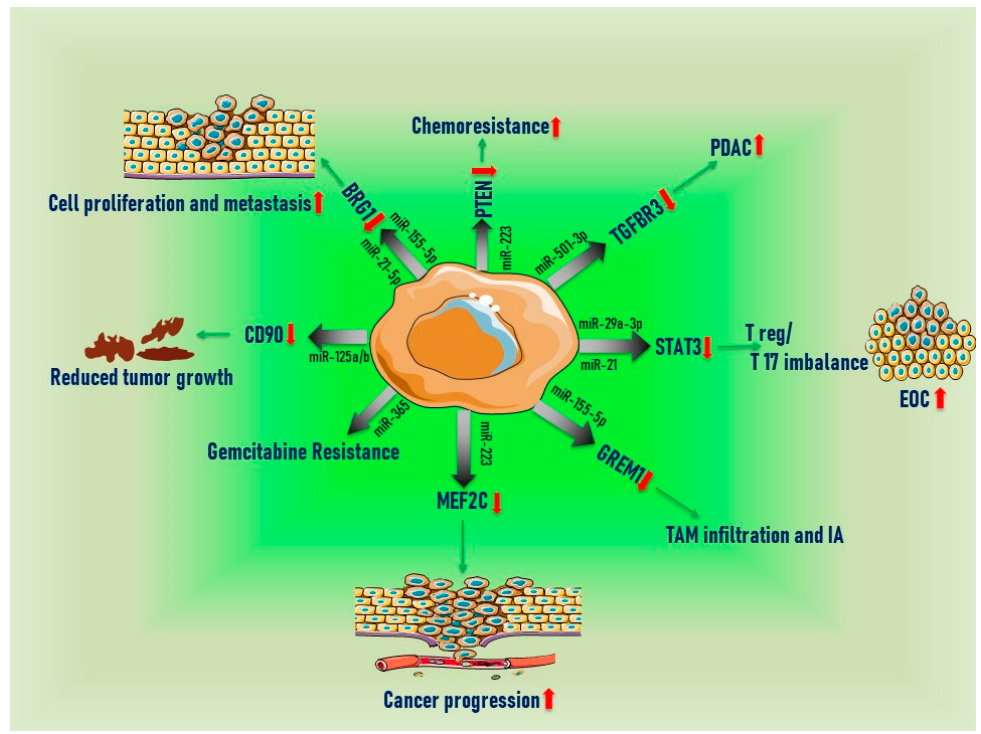
Figure 2. Extracellular miRNAs secreted from TAMs. (red arrows showing the increase or decrease in target gene expression or tumor growth) target gene expression or tumor